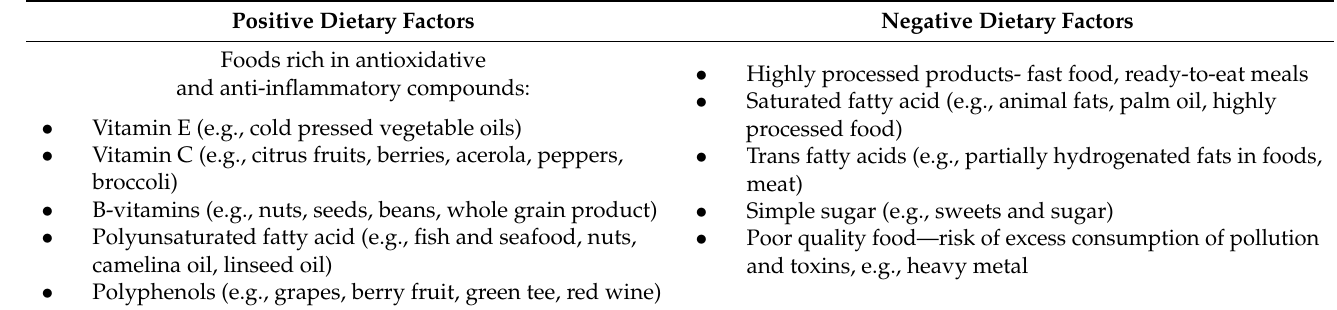
Table 2. The influence of nutritional factors on the prevention of Alzheimer’s